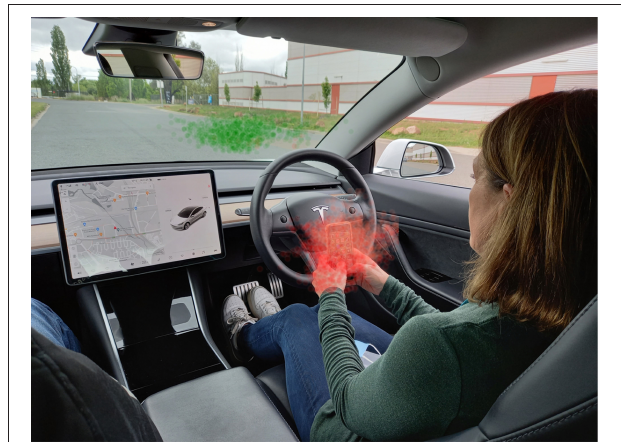
FIGURE 1 | Example of a driver using of a mobile phone with a driver assistance feature. Indicative metrics are presented for eye gaze (red) and head pose (green) when a driver uses a lizard glance strategy while looking at mobile